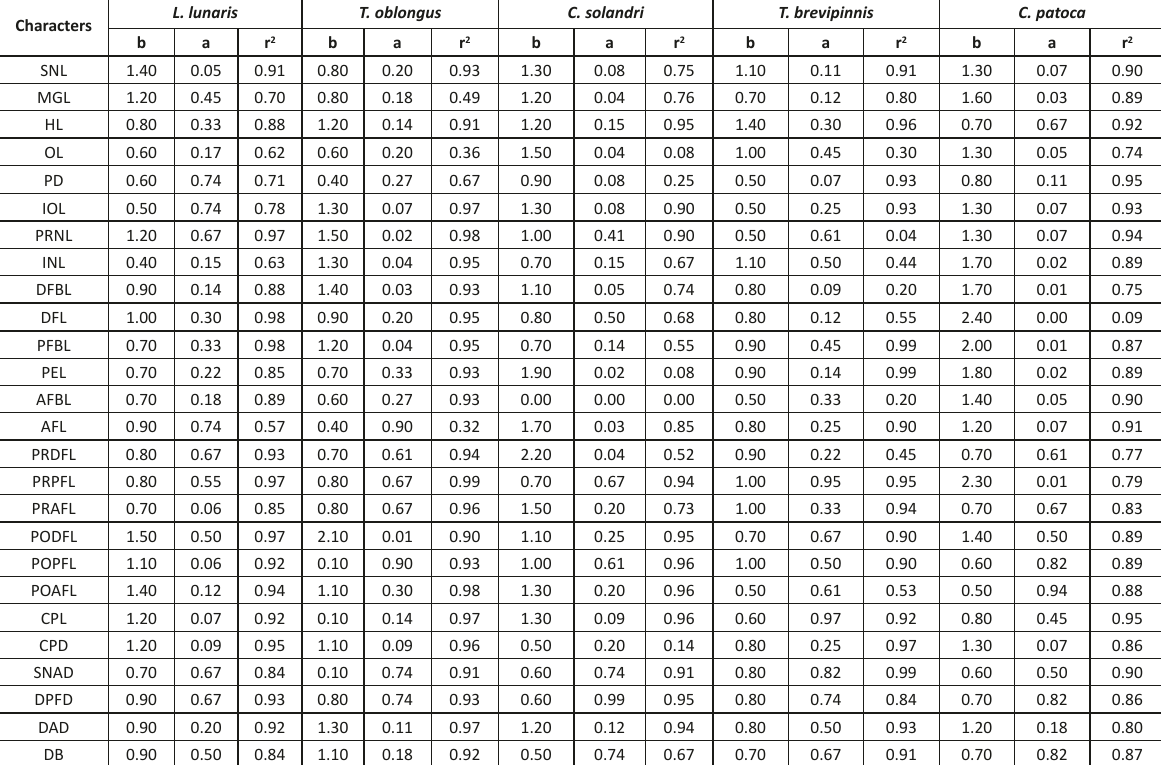
Table 3b. The relationship between all the characters and standard length of Tetradontidae from southeastern India, P<0.01. L. Characters